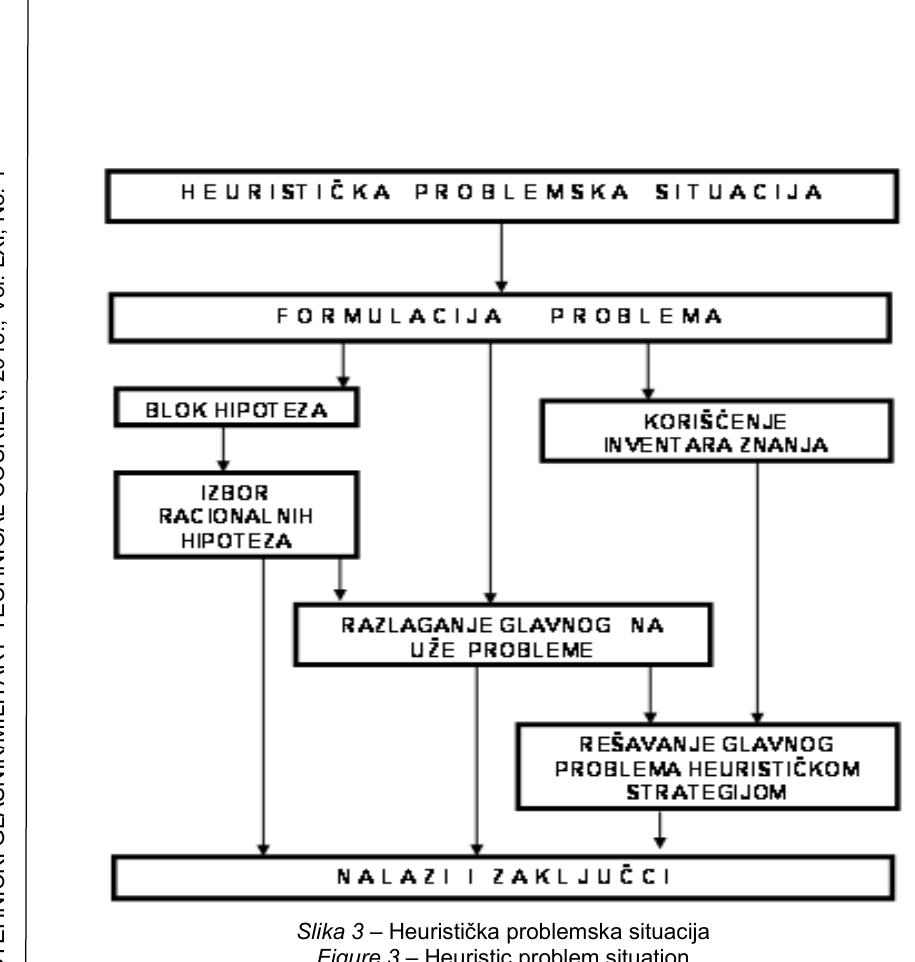
Figure 3 – Heuristic problem